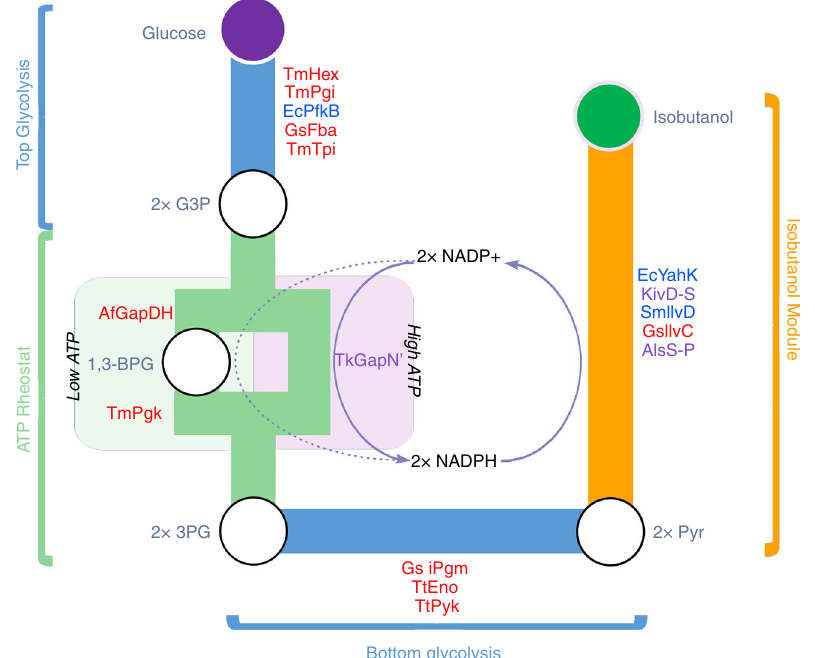
Fig. 1 Schematic of synthetic biochemistry pathway for conversion of glucose to isobutanol. Enzymes used in this pathway are described in Table 1. Enzymes in red are from hyperthermophilic organisms, enzymes in blue are mesophilic and enzymes highlighted purple are designed speci fi cally for this study. G3P glyceraldehyde-3-phosphate; 3PG 3-phosphoglycerate; 1,3-BPG 1,3-bisphosphoglycerate; Pyr pyruvate. The logic of the system including the rheostat are described in Opgenorth et al. 27